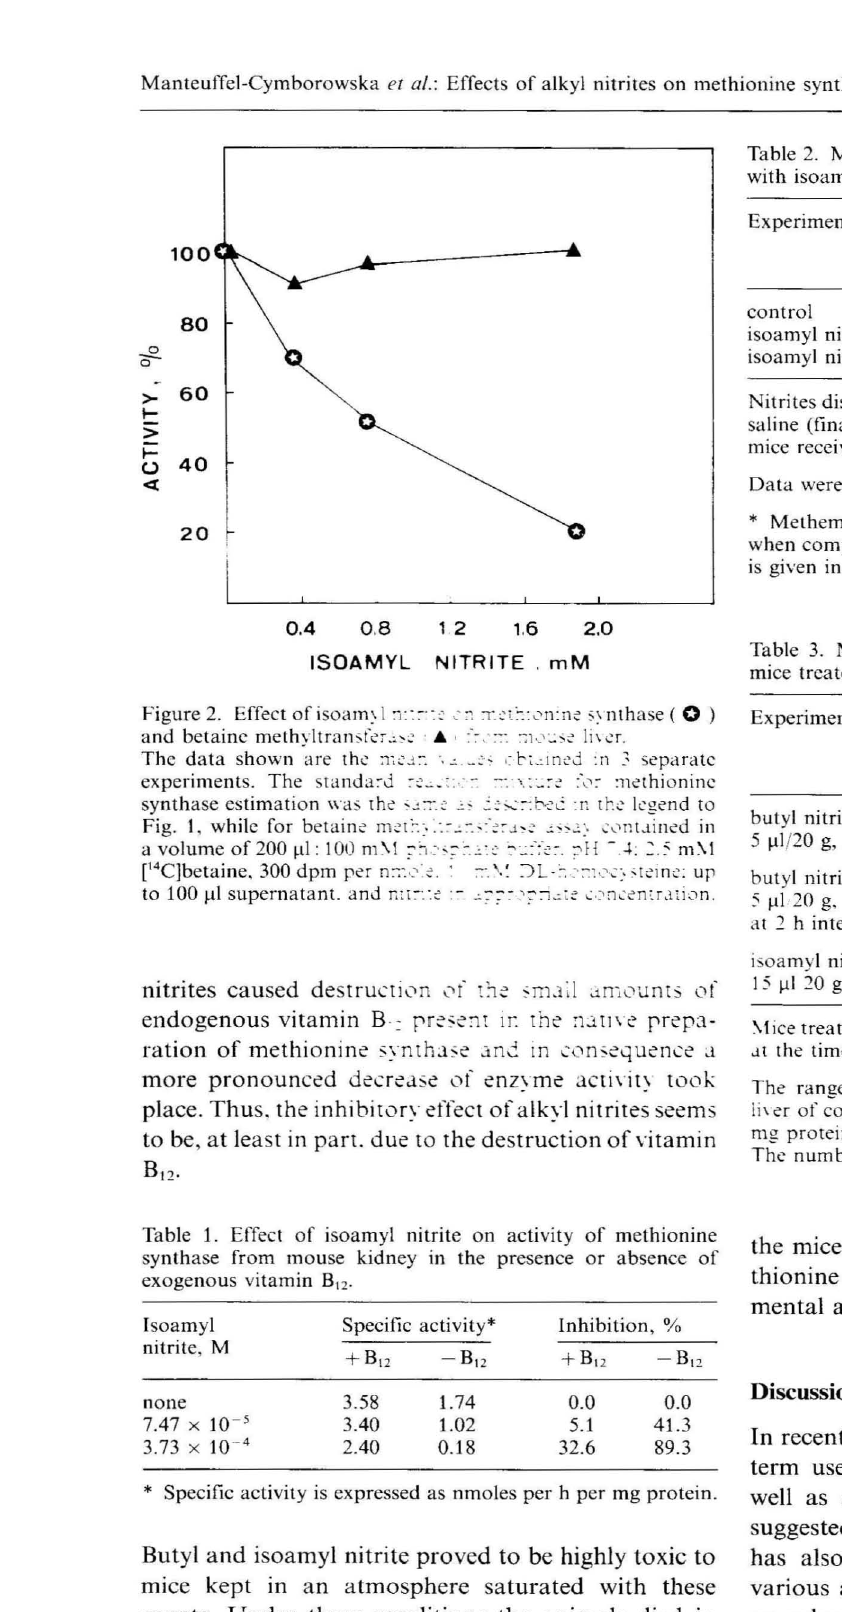
Table 2. Methemoglobin levels in mouse blood after treatment with isoamyl nitrite. Experimental